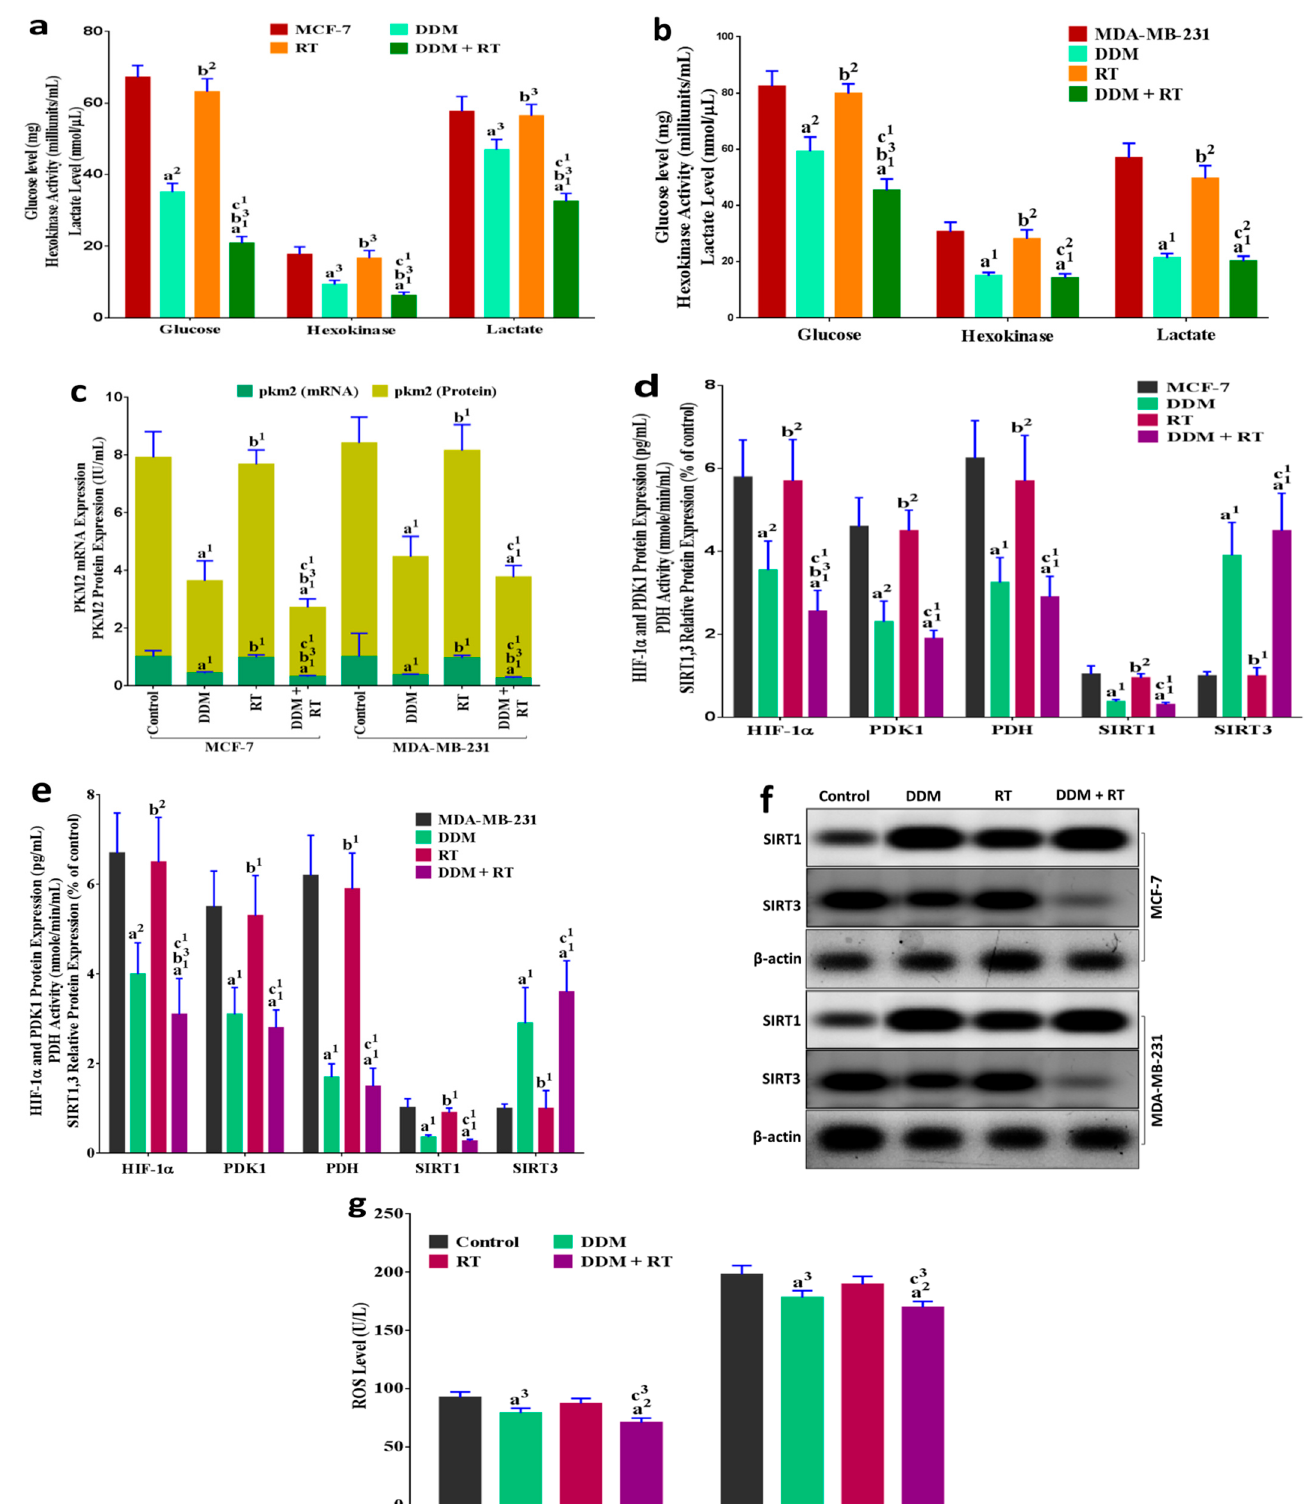
Figure 6. The influence of DDM and/or RT on glycolysis and mitochondrial metabolic pathways in BC cells. ( a , b ) Glucose, hexokinase, and lactate levels were analyzed by colorimetric assay in all groups. ( c ) mRNA and protein expression of PKM2 was rescued in all groups. ( d , e ) HIF-1 α , PDK1, SIRT1, and SIRT3 protein expression and PDH enzymatic activity was rescued in all groups. ( f ) Relative SIRT1, SIRT3, and β -actin protein levels in all groups. ( g ) ROS levels (ELISA) in all groups. All group values are given as the mean ± standard error of the mean (SEM). a1 p < 0.001, a2 p < 0.01, a3 p < 0.05 vs. control; b1 p < 0.001, b2 p < 0.01, b3 p < 0.05 vs. DDM group; c1 p < 0.001, c2 p < 0.01, c3 p < 0.05 vs. RT group.